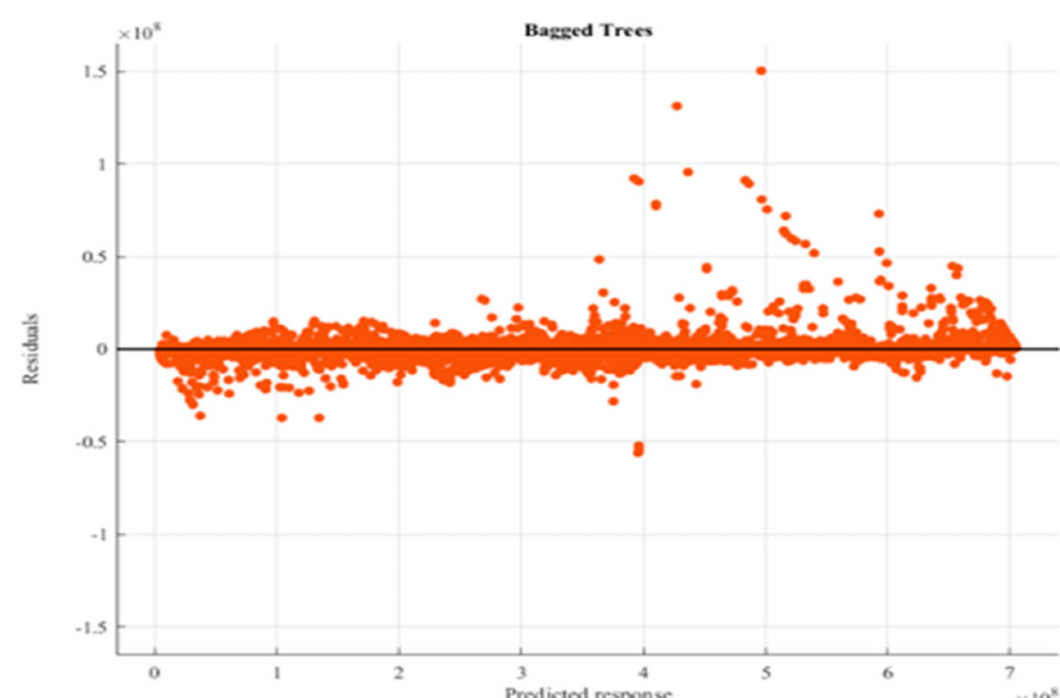
Figure 20. Bagged Trees Residual